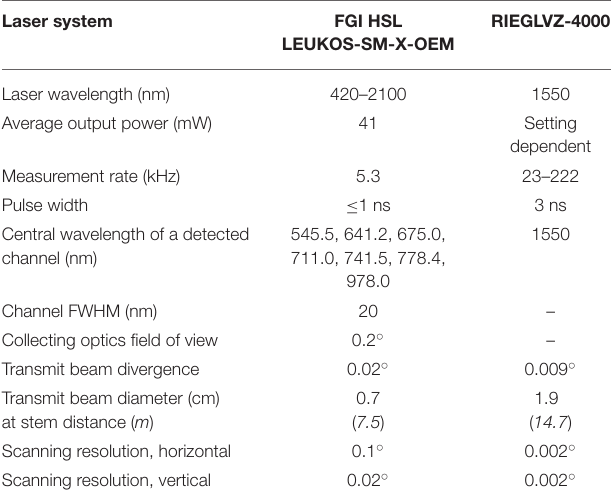
TABLE 1 | Property comparison between the laser scanners used in the Finnish and Austrian test sites. Laser